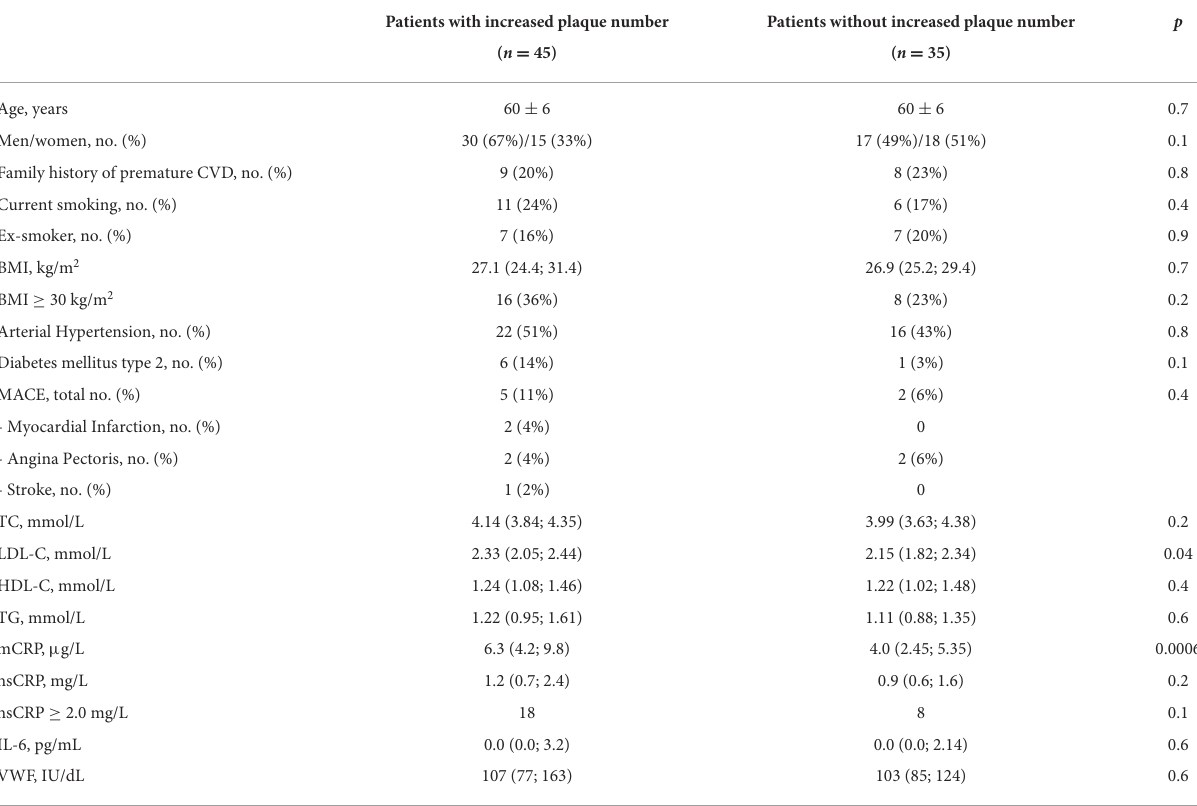
TABLE 2 The characteristics of the patients at the 7th-year follow-up survey.